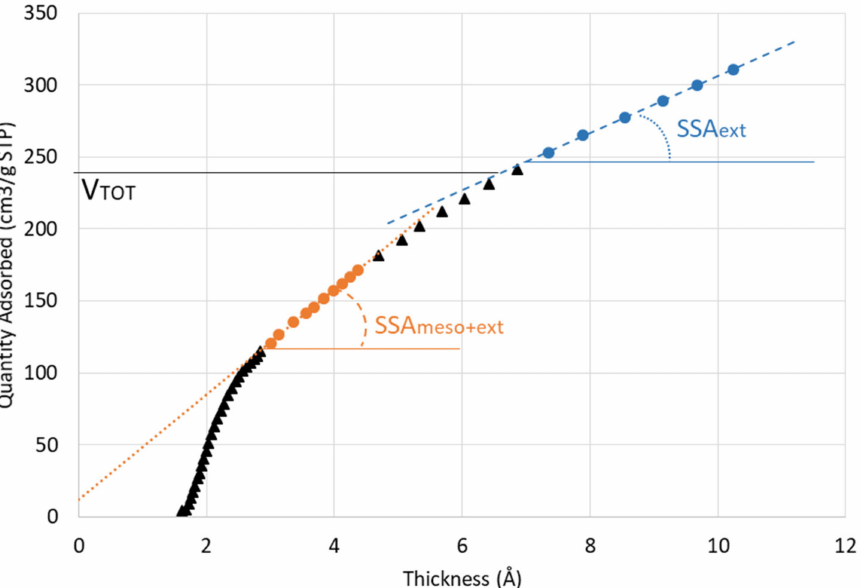
Figure 2. Illustration of the t-plot on an M-S-H paste highlighting the external surface area (SSA ext ), the pore volume (V TOT ), and the total specific surface area (SSA meso + ext ), which corresponds to the specific surface area calculated with BET (after Galarneau et al.